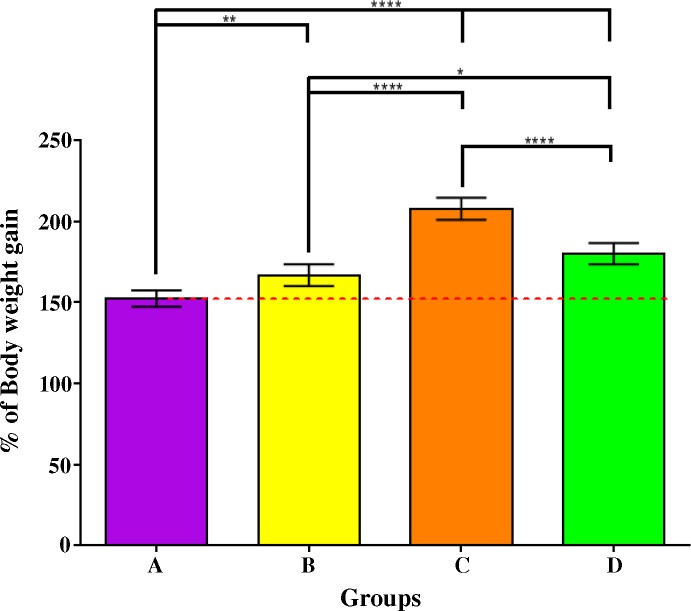
Wide-ranging differences among the relative body weight gains in Asian seabass fed pelleted feeds compared to control.Total percentage of body weight gain after the consumption of three different pelleted feeds (Feeds B-D) relative to frozen baitfish (Feed A) during a two-month period (107–168 days post-hatch). Post-ANOVA Tukey's multiple comparison test was performed to compare the mean values of every group. Error bars are plotted with 95% confidence intervals from the mean. Significantly different means are noted with *—Padj < 0.05; **—Padj < 0.01; ***—Padj < 0.001; and ****—Padj < 0.0001.